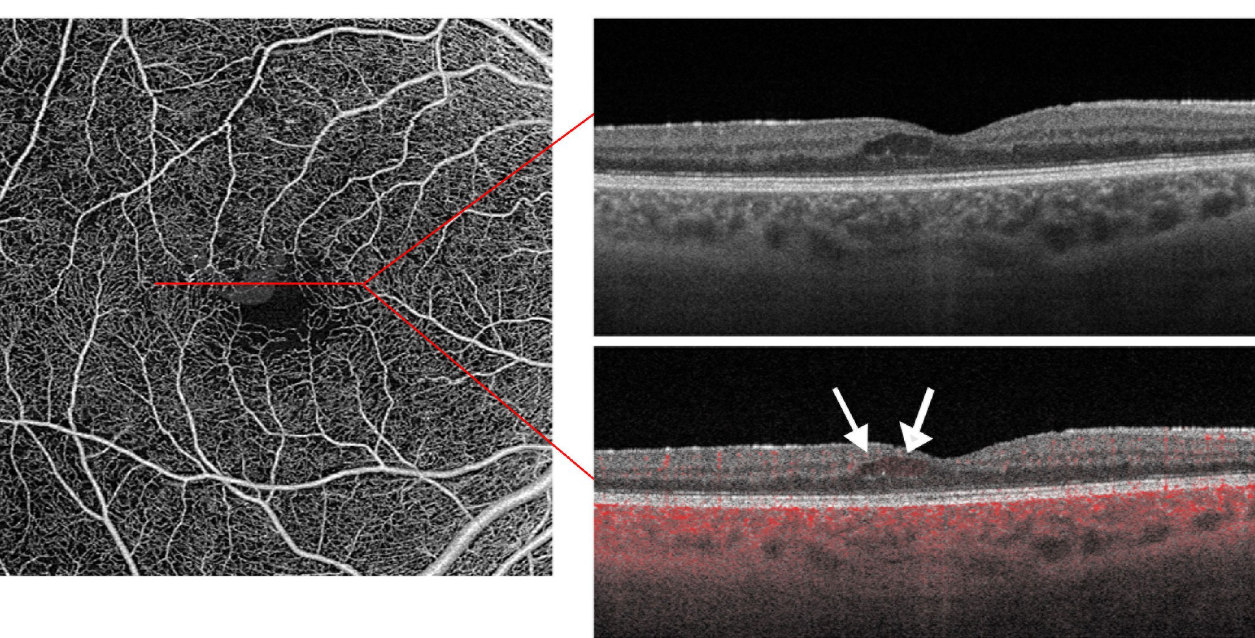
Fig 2. Example of annotated artifacts with flow in the cysts on OCTA images. On the left is an OCTA image of the retina slab. On the upper and lower right a B-scan of the location marked by the red line. On the upper right the B-scan is shown without perfusion representation, on the lower right with perfusion in red. The white arrows mark the perfusion visible in the cyst.